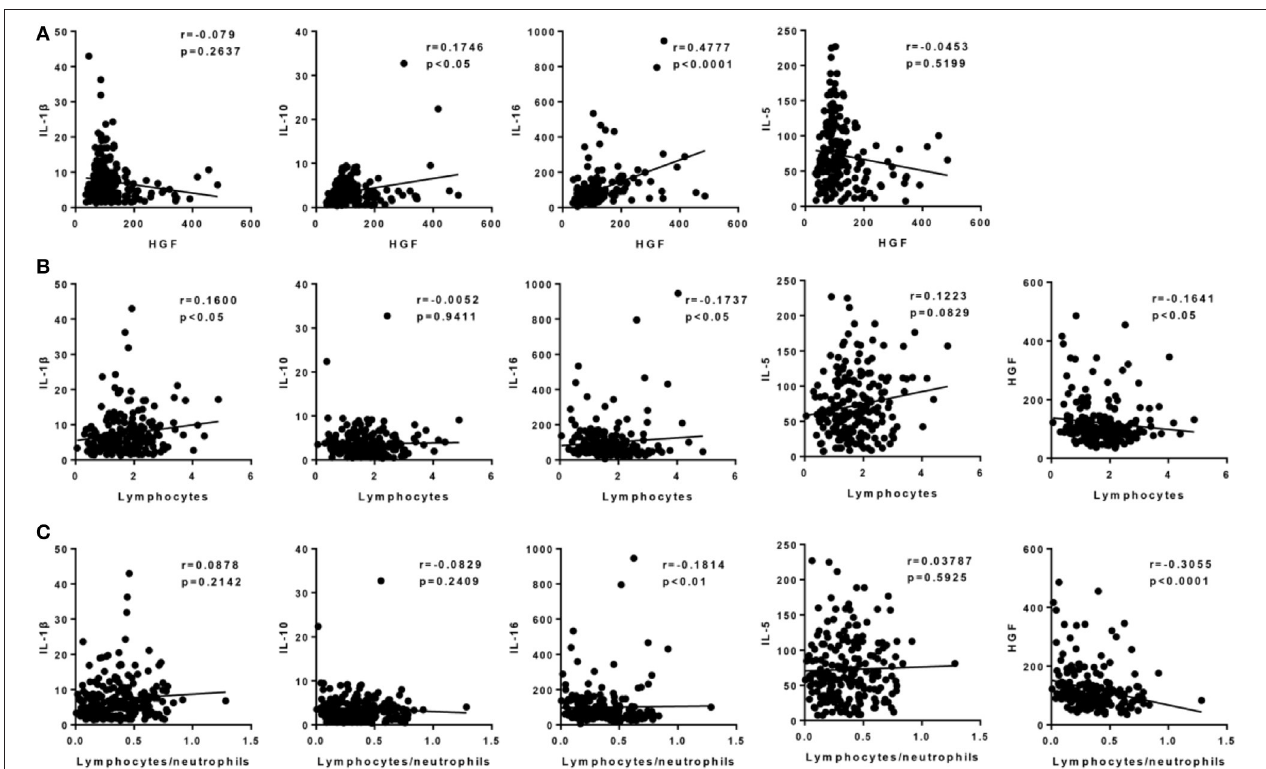
FIGURE 3 | Correlation analyses between circulating HGF and the related interleukins (IL-1 β , IL-5, IL-10, and IL-16) in AIS patients. (A) Correlation between circulating HGF and other four parameters within 24h after stroke attack. (B) Correlation between the number of circulating lymphocytes and the five parameters within 24h after stroke attack. (C) Correlation between lymphocyte-to-neutrophil ratio and the five parameters within 24h after stroke attack. N = 202.